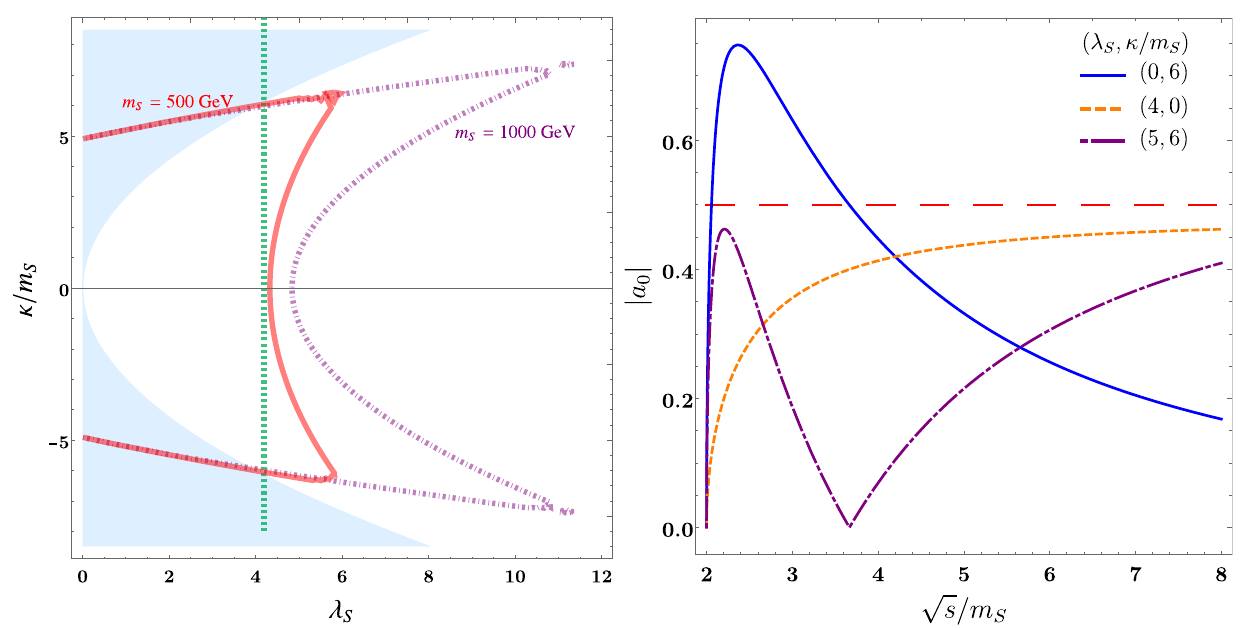
Fig. 2 Unitarity constraints on the pure singlet model (18). Left: the solid red and dashed purple lines correspond to m S = 500 , 1000 GeV respectively (or other arbitrary units relative to